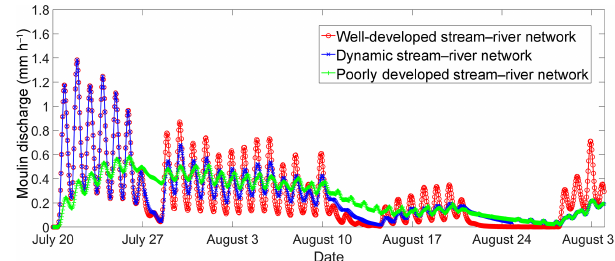
Figure 7. Simulated Rio Behar catchment discharge at the terminal outlet moulin for 20 July to 31 August 2015 assuming a seasonally evolving supraglacial stream–river network. A series of contribut- ing area thresholds ( A c ) of 250, 500, 1000, 2500, and 5000 pix- els is used to mimic an evolving supraglacial stream–river drainage network from the 18 July 2015 WorldView DEM. The minimum A c (250 pixels) is used to simulate well-developed river networks, while the maximum A c (5000 pixels) is used to simulate poorly developed river networks. Variable A c values are used to simulate dynamic river networks, which are considered to best capture real- istic seasonal evolution. Drainage density is lowest in the early and late season and highest in July. The diurnal variations in moulin dis- charge are strongly controlled by supraglacial stream–river network